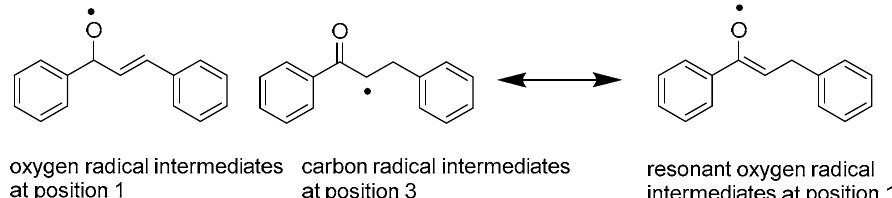
Figure 5. Cyclic voltammetry (CV) of A, B, and BH 2 (R=CH 3 ) in deaerated acetonitrile containing 0.1 M n-Bu 4 NPF 6 as supporting electrolyte.